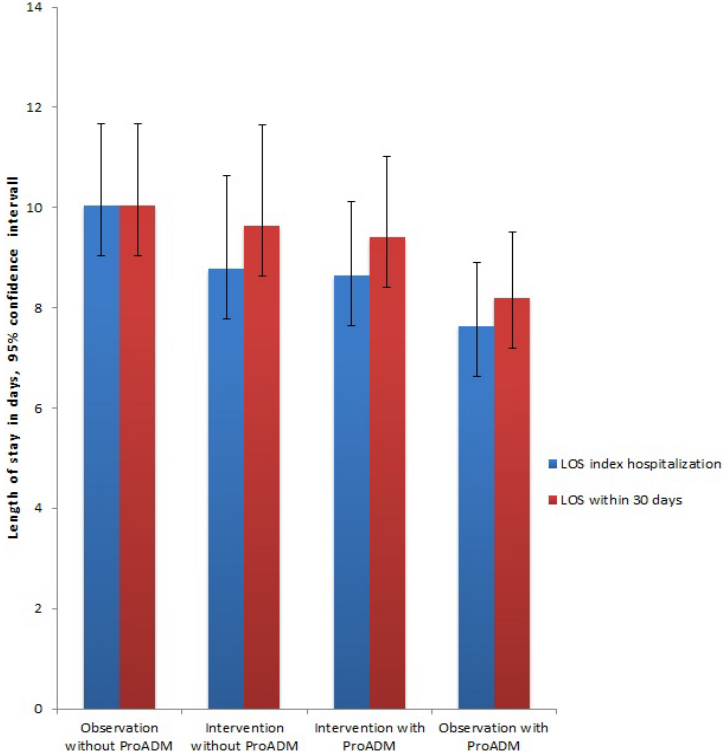
Figure 2. Length of stay during index hospitalization and within 30 days after